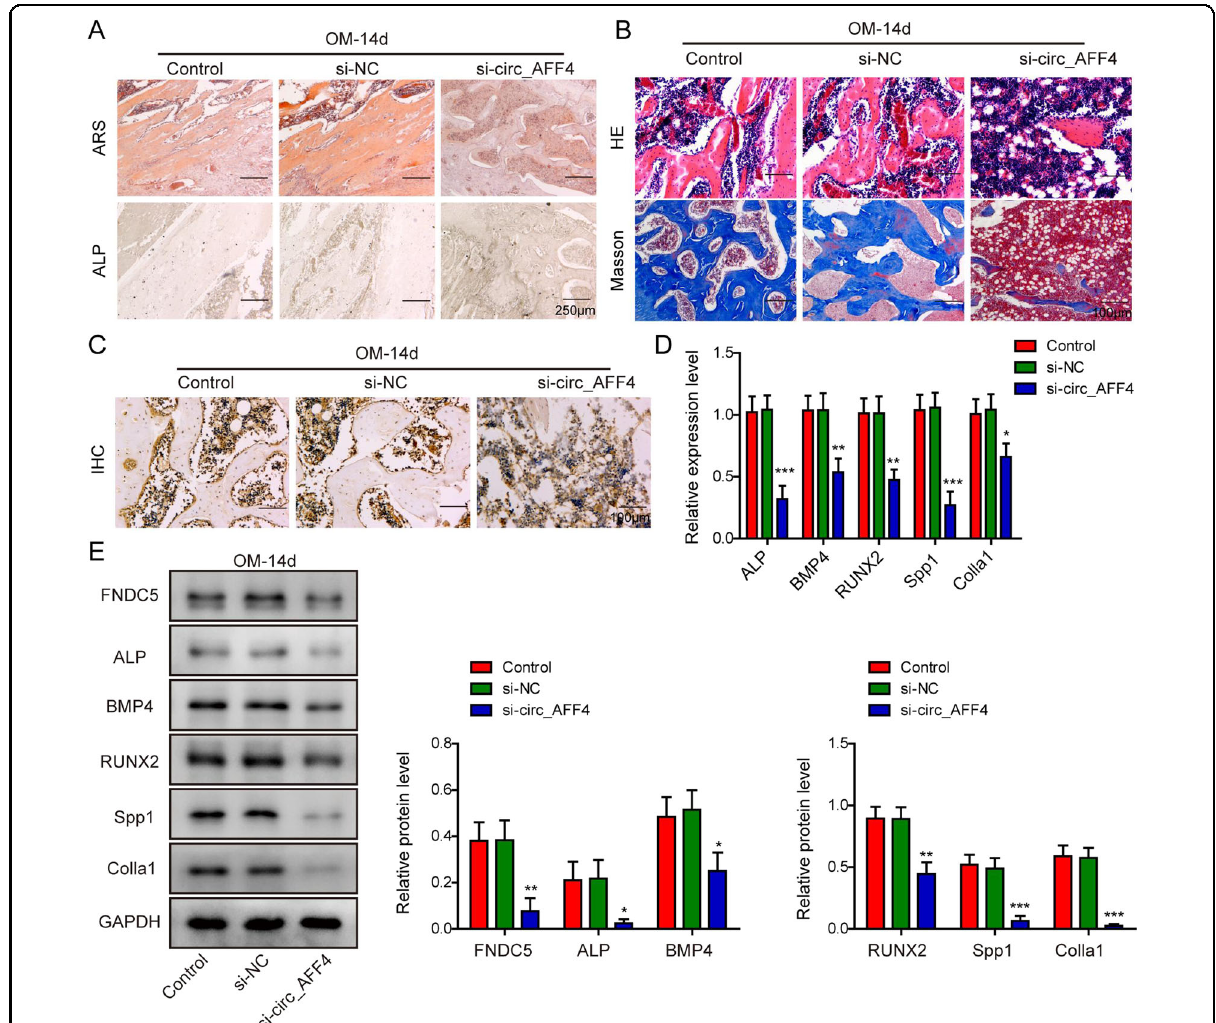
Fig. 8 In vivo bone formation was inhibited by circ_AFF4 knockdown. BM-MSCs were transfected with si-circ_AFF4 or siRNA negative control (NC) and further cultured in OM for 7 days. BALB/c nude mice were injected with the BM-MSCs above and femurs were removed after 8 weeks. A ARS and ALP staining assays were performed to compare the bone cell formation in mice treated with si-circ_AFF4 or si-NC. B Representative images of H&E and Masson staining in mouse femurs showing the in vivo bone formation and collagen deposition, respectively. C Expression of the osteogenic differentiation-related transfection factor RUNX2 was evaluated using IHC staining. qRT-PCR ( D ) and WB ( E ) were conducted to determine the expression levels of osteogenic marker genes ALP, BMP4, RUNX2, Spp1, and Colla2 in femur samples from mice treated with si-circ_AFF4 or siRNA NC. The data were shown as mean ± SD based on at least three independent experiments. * P < 0.05, ** P < 0.01, and *** P <